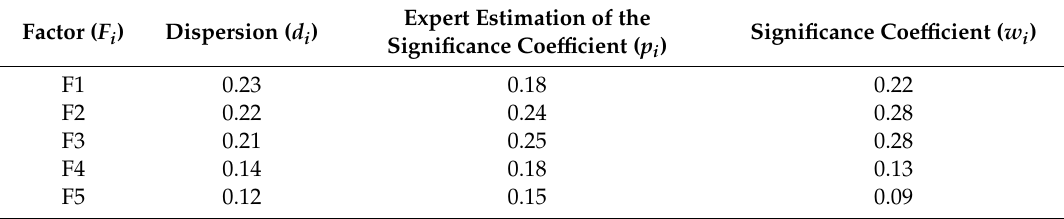
Table 5. Factor significance in estimating the scientific activity output.